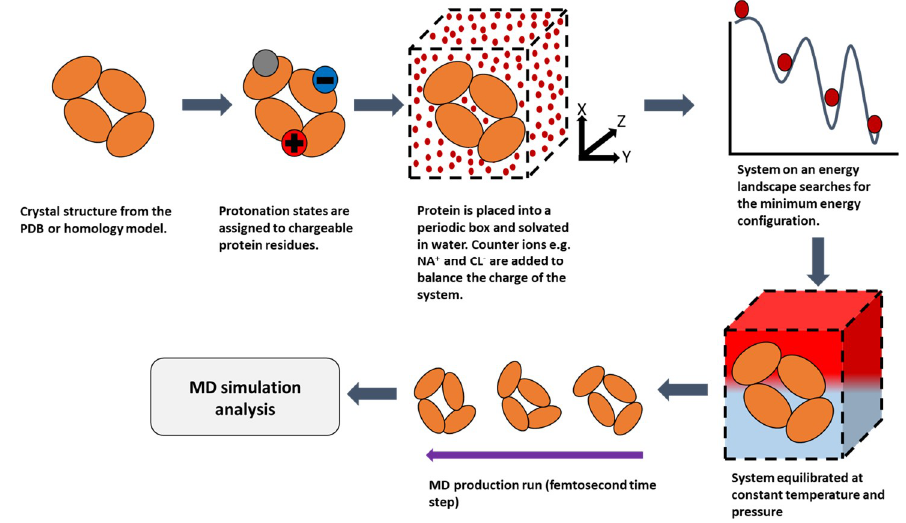
Table 2. The typical molecular dynamics (MD) simulations timescales that can observe various protein dynamics events.